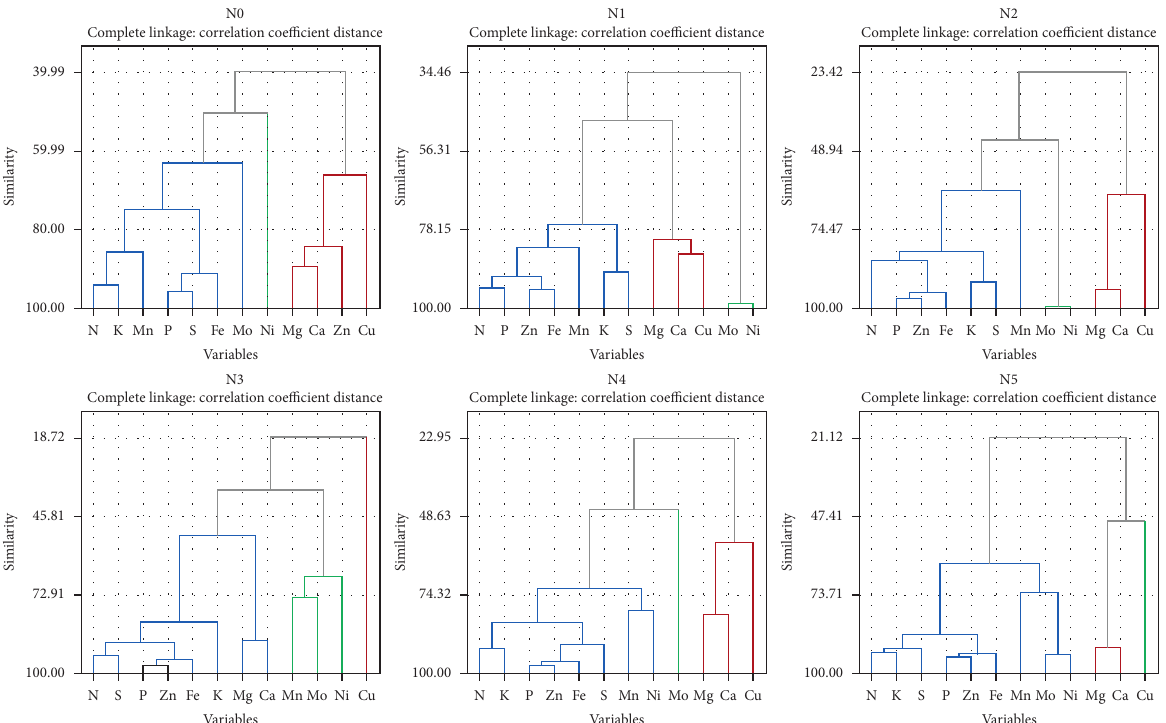
Figure 1: Cluster of NPK in nutrients with means of sampling times on leaves. Nitrogen (N), potassium (K), phosphorus (P), magnesium (Mg), calcium (Ca), sulphur (S), zinc (Zn), iron (Fe), copper (Cu), manganese (Mn), nickel (Ni), and molybdenum